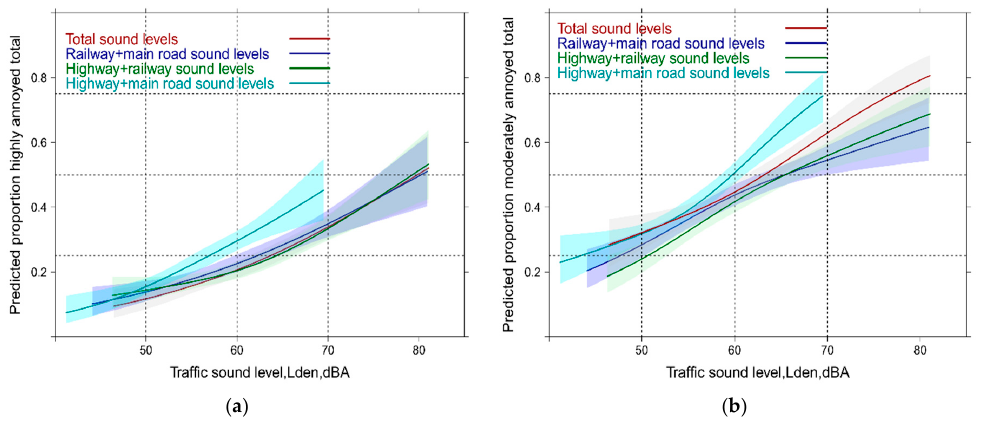
Figure 2. Predicted proportion of total high and moderate annoyance associated with mixed sound level exposure. ( a ) Proportion highly annoyed; ( b ) Proportion moderately annoyed.